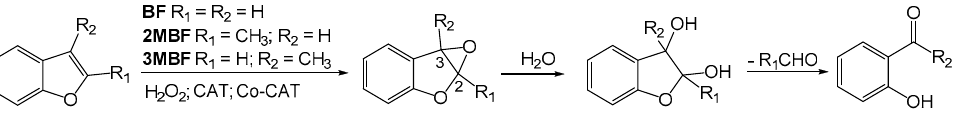
Figure 4. GC-FID chromatograms (between 0–90 min) for BF oxidation by H 2 O 2 using CAT I and ammonium acetate as co-catalyst.